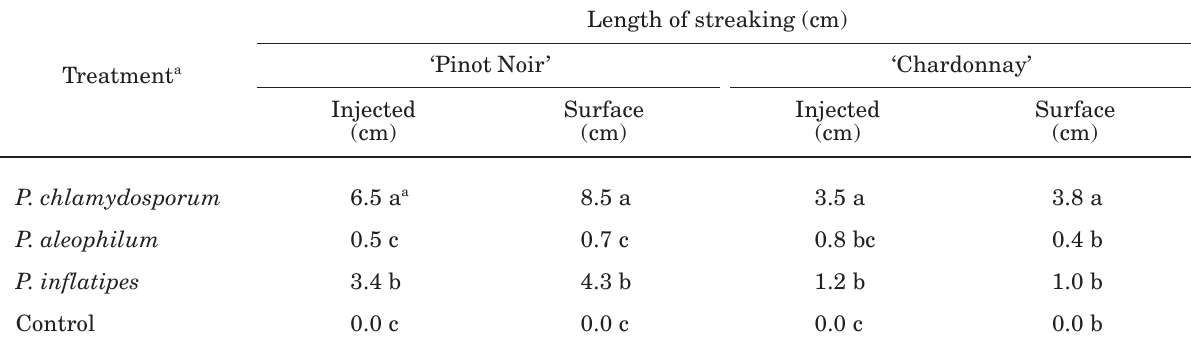
Table 7. Progress of streaking (cm) from the point of inoculation, caused by Phaeoacremonium chlamydosporum, P. aleophilum and P. inflatipes in the inoculated spurs of grapevine cv. Chardonnay and Pinot Noir. Pathogens were either injected into the pith or applied as a drop of spore suspension to the cut surface of grapevine